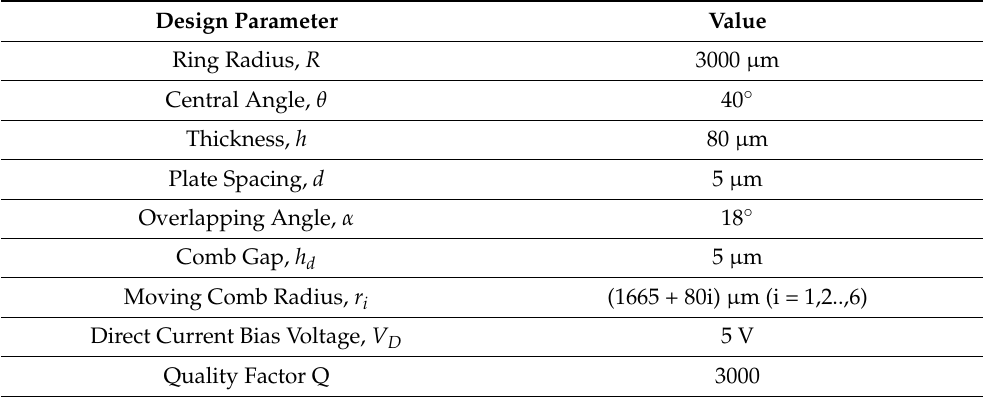
Table 3. Values for design